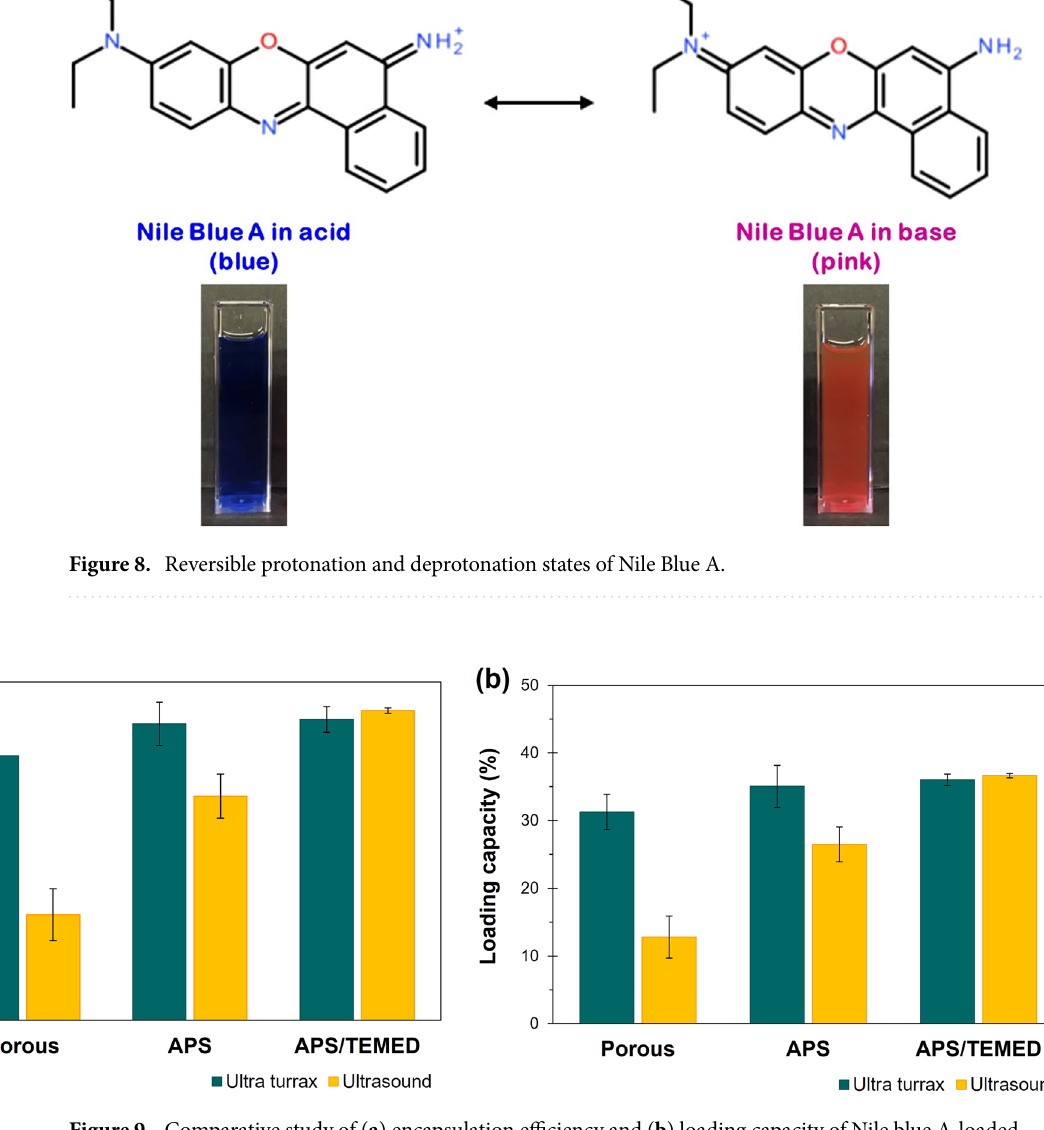
Figure 9. Comparative study of ( a ) encapsulation efficiency and ( b ) loading capacity of Nile blue A-loaded particles prepared by ultra turrax (UT) and ultrasound (US) in the second